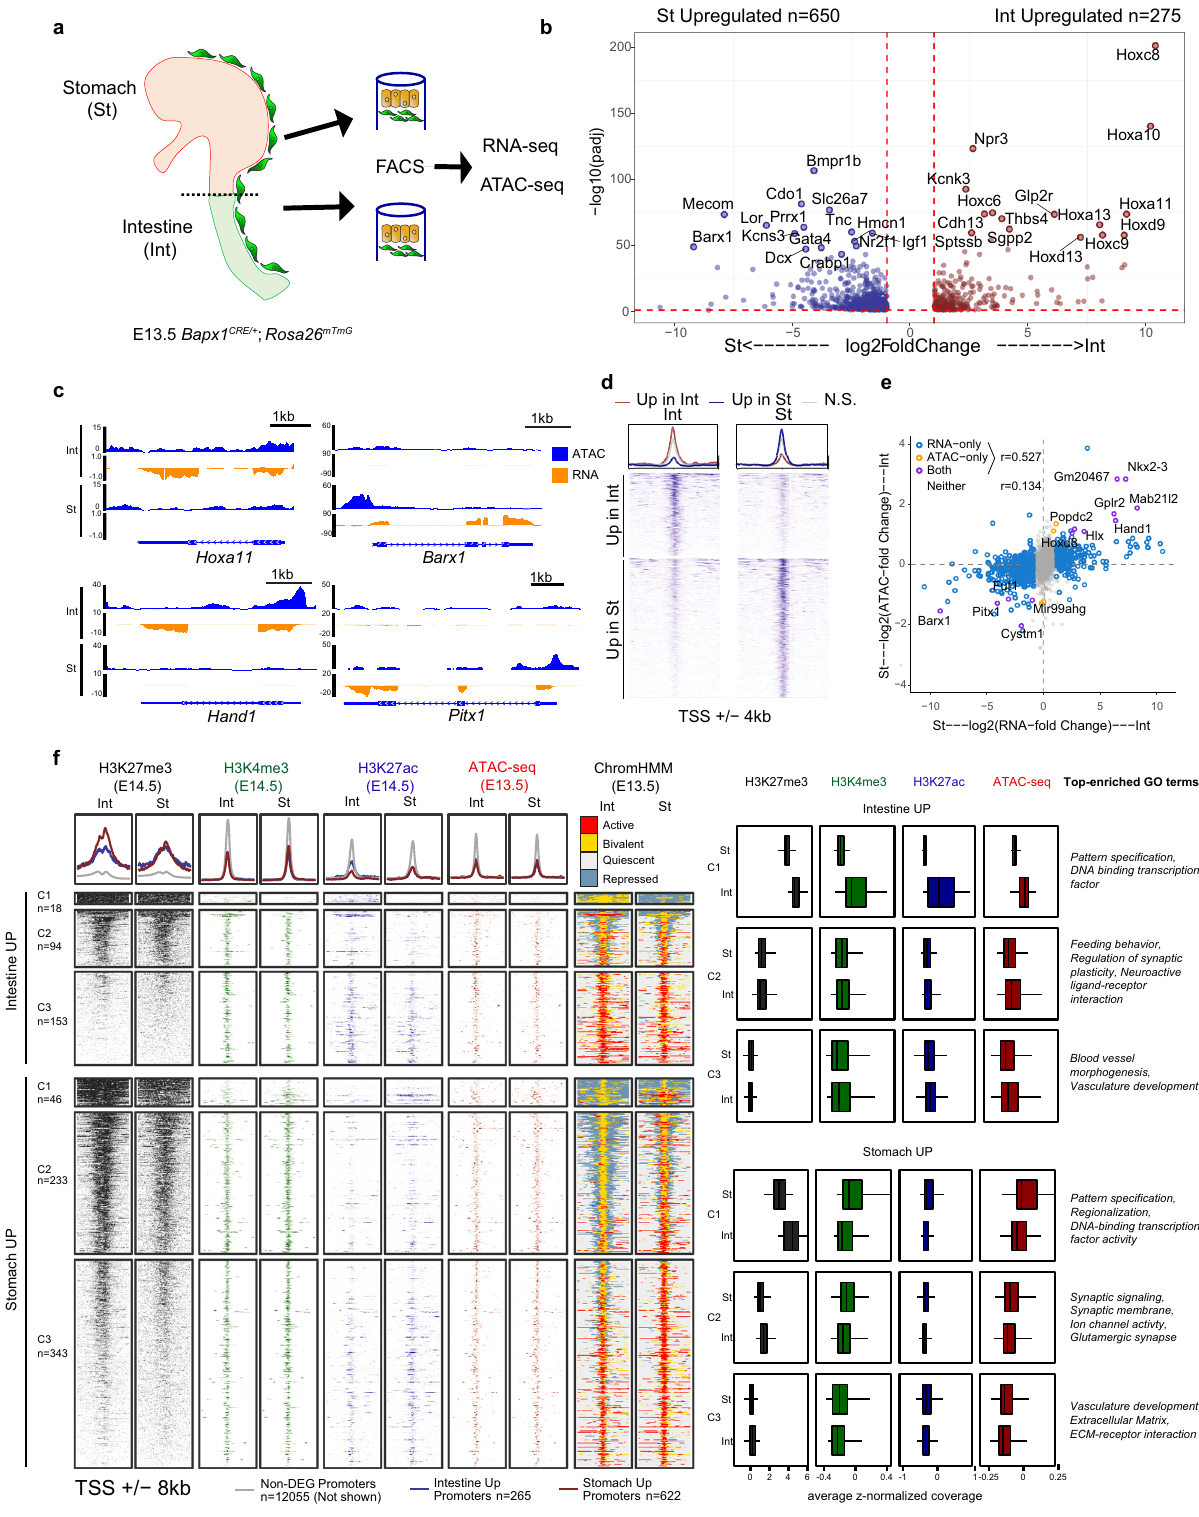
GI speci fi cation and regionalization, we genetically inhibited PRC2 function in the mesenchyme of the primitive gut tube by deleting Embryonic Ectoderm Development ( Eed ), a core component of PRC2 ( Bapx1 Cre/+ ; Eed fl / fl ) (Fig. 2a). Immuno fl uorescence staining of